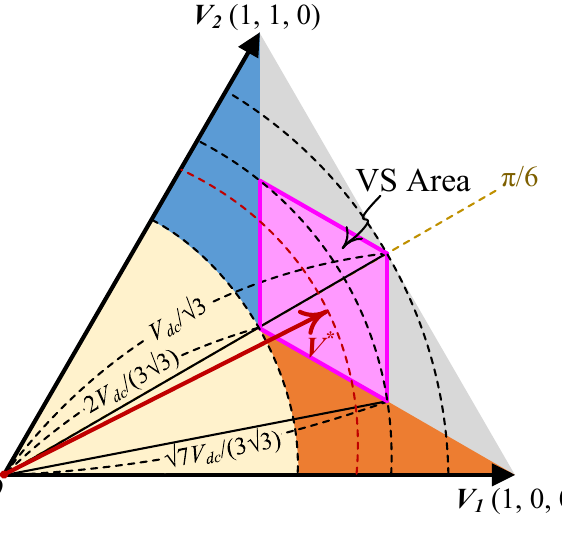
Figure 10. Range of vs. area of sectors 1 and 2.